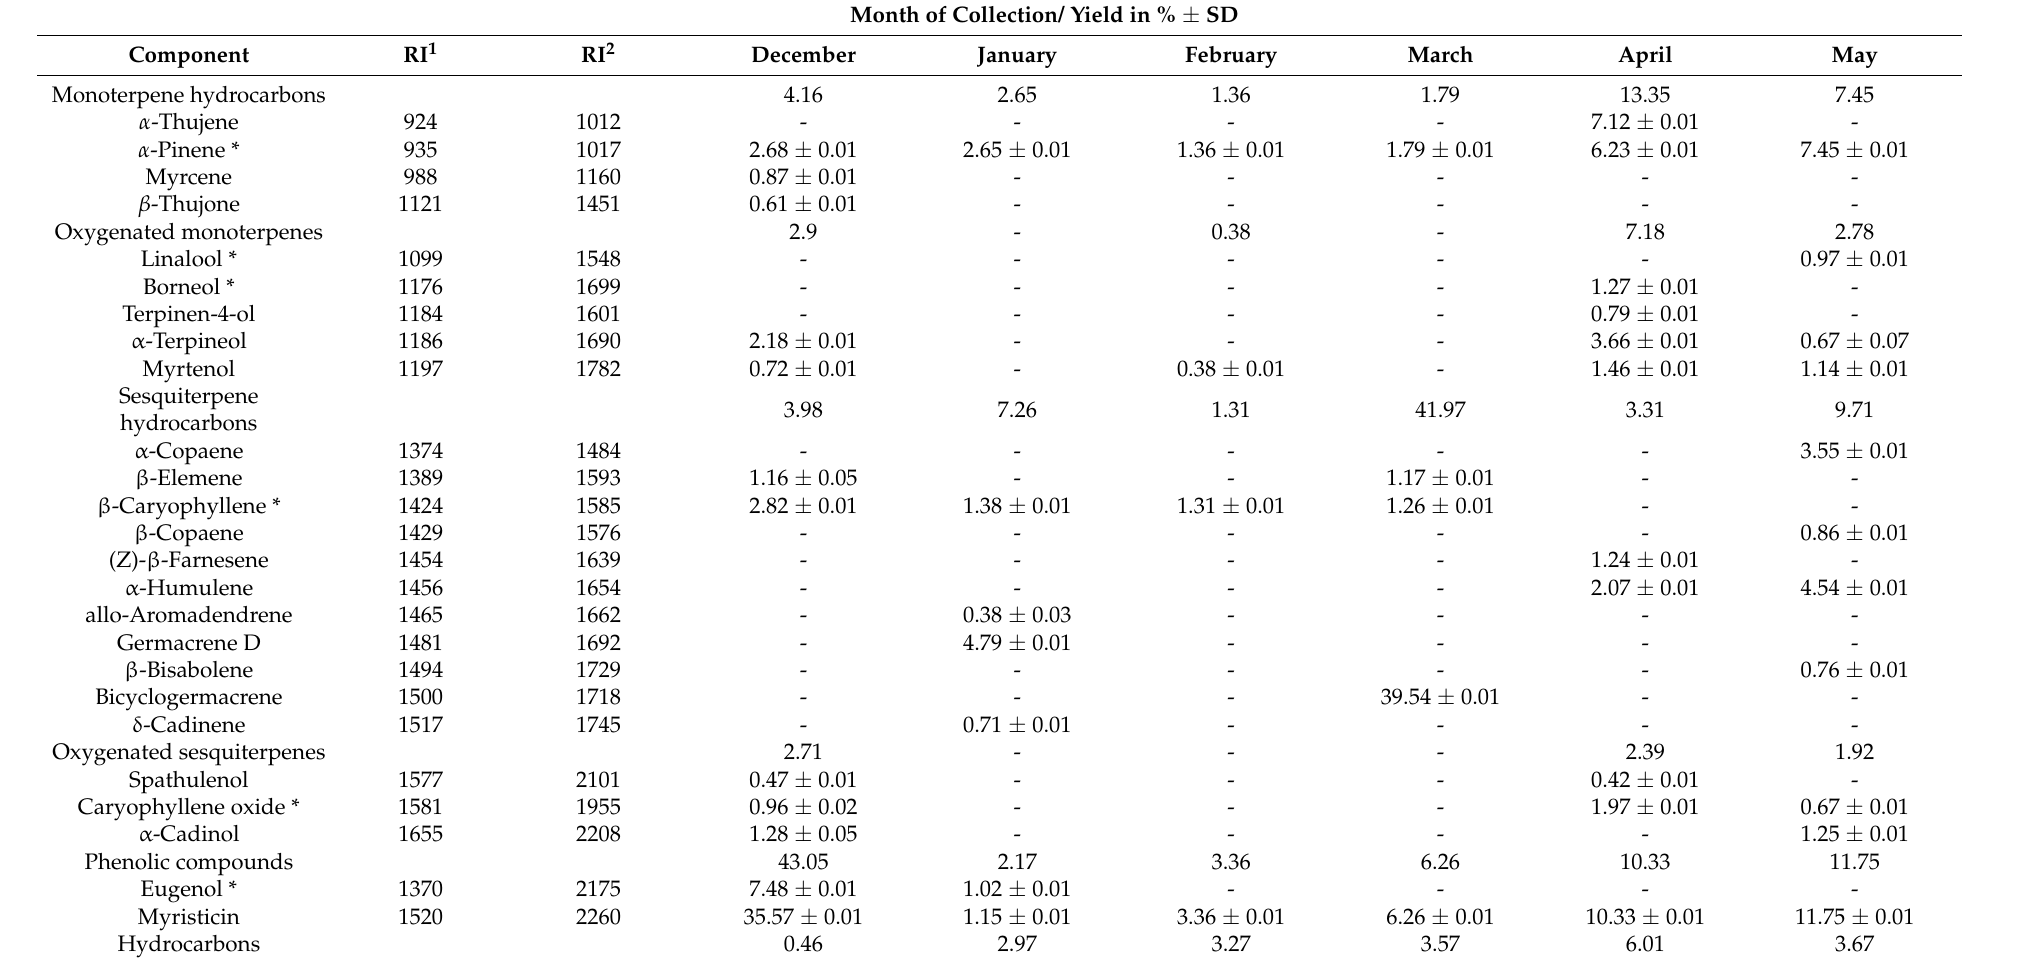
Table 3. Chemical composition of the hydrosols of Olea europaea L. cv. Oblica from six